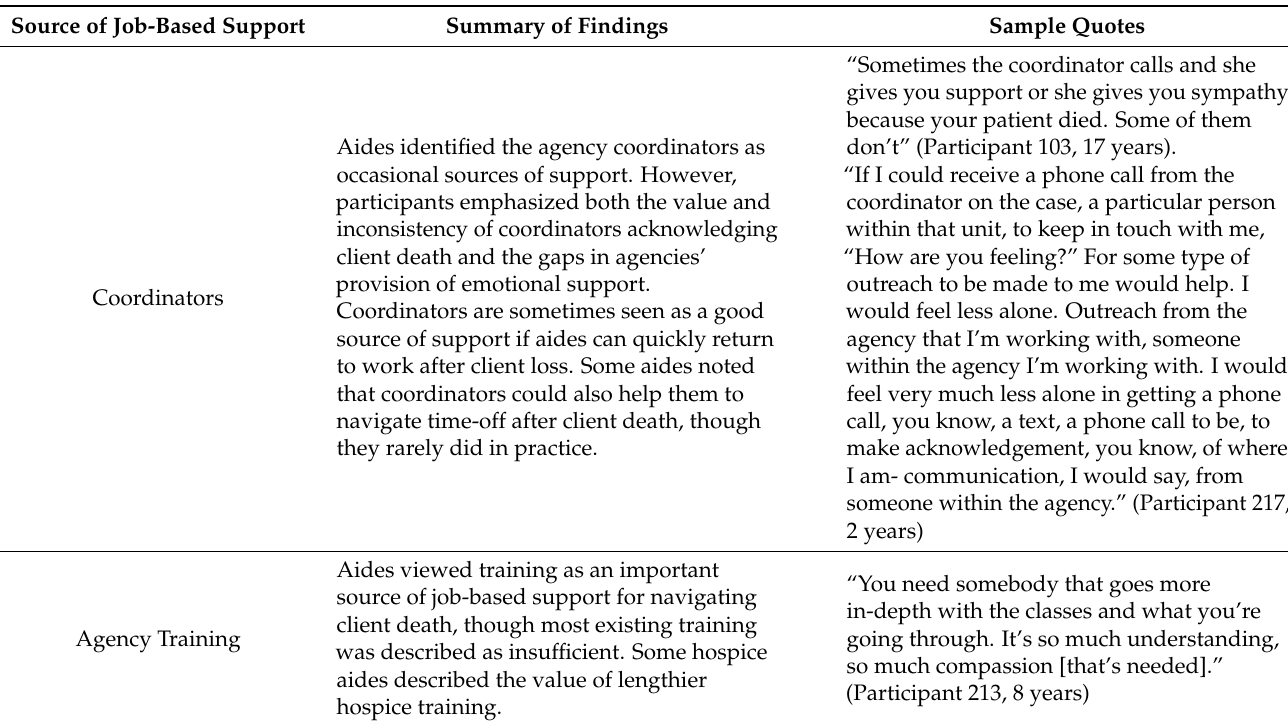
Table 2. Summary of findings on aides’ experiences of job-based